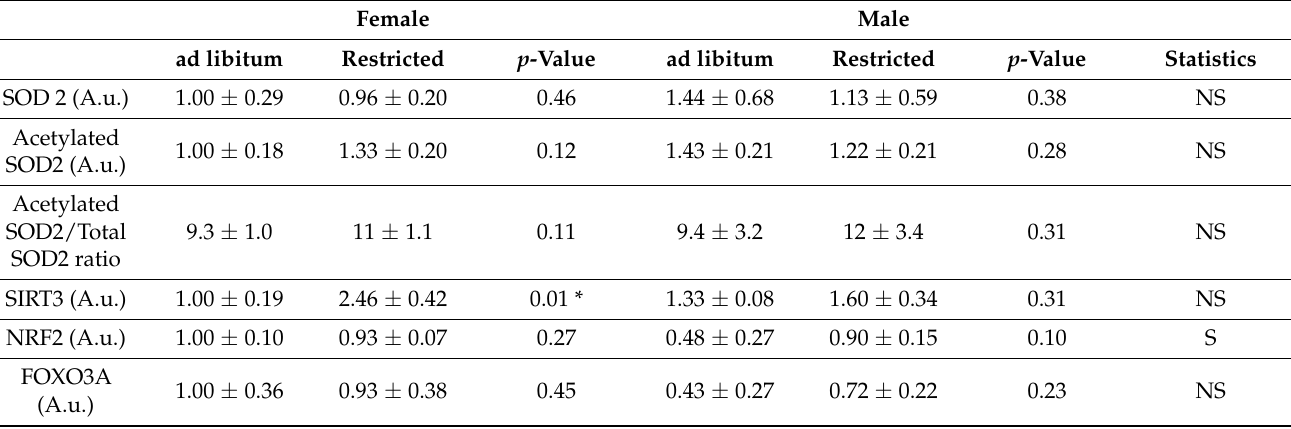
Table 4. Protein levels of antioxidant enzymes and factors analyzed by Western Blot. Two-way ANOVA was performed to assess for significance. Abbreviations: S, sex differences; NS, non- significant. * Statistical differences between calorie restricted and control